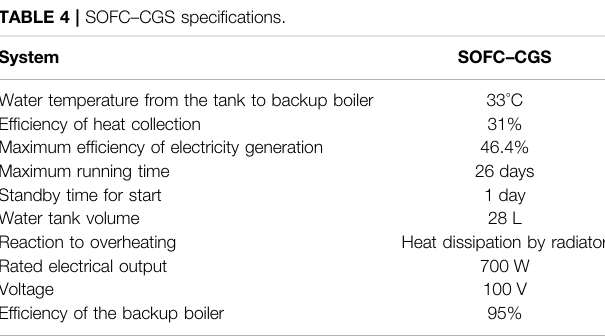
TABLE 4 | SOFC – CGS speci fi